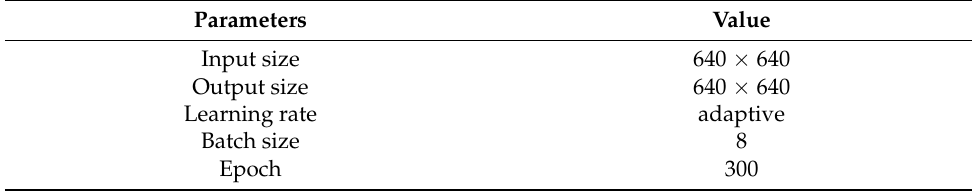
Table 2. Training parameters.